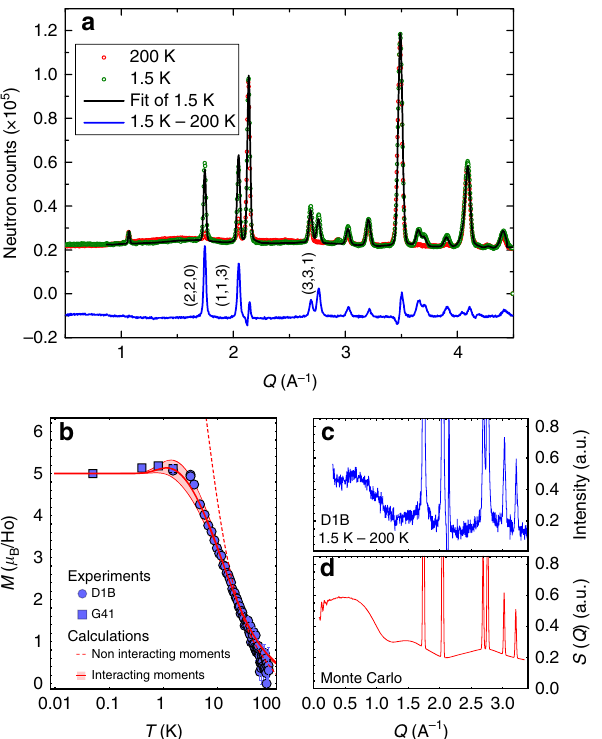
Fig. 2 Magnetic ordering and diffuse scattering in Ho 2 Ir 2 O 7 . a Neutron diffractograms recorded at 200 K ( red dots ) and 1.5 K ( green dots ) showing the rise of magnetic Bragg peaks. The 1.5 K Rietveld re fi nement ( black line ) using a k = 0 propagation vector yields an AIAO magnetic order for the holmium sublattice. The difference between the 1.5 and 200 K data ( blue line , shifted for clarity) enhances the magnetic Bragg peaks. b Temperature evolution of the re fi ned Ho 3+ magnetic moment, in a semi- logarithmic scale, measured with two diffractometers (D1B and G4.1). The red dashed curve is the calculated ordered magnetic moment induced by the temperature dependent molecular fi eld created by the Ir magnetic ordering.